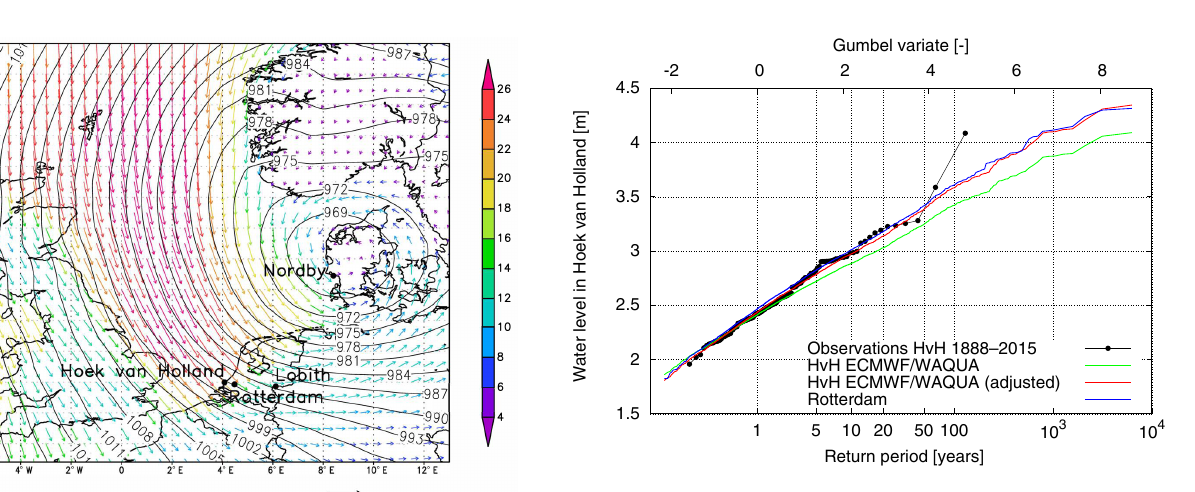
Figure 5. Gumbel plot of the annual maximum water levels in Hoek van Holland according to the observations (black) and the ECMWF- WAQUA/DCSMv5 ensemble (red). Adjusting the Gumbel parame- ters of the ECMWF-WAQUA/DCSMv5 ensemble to match the ob- served Gumbel parameters (according to Eq. 10) results in the blue